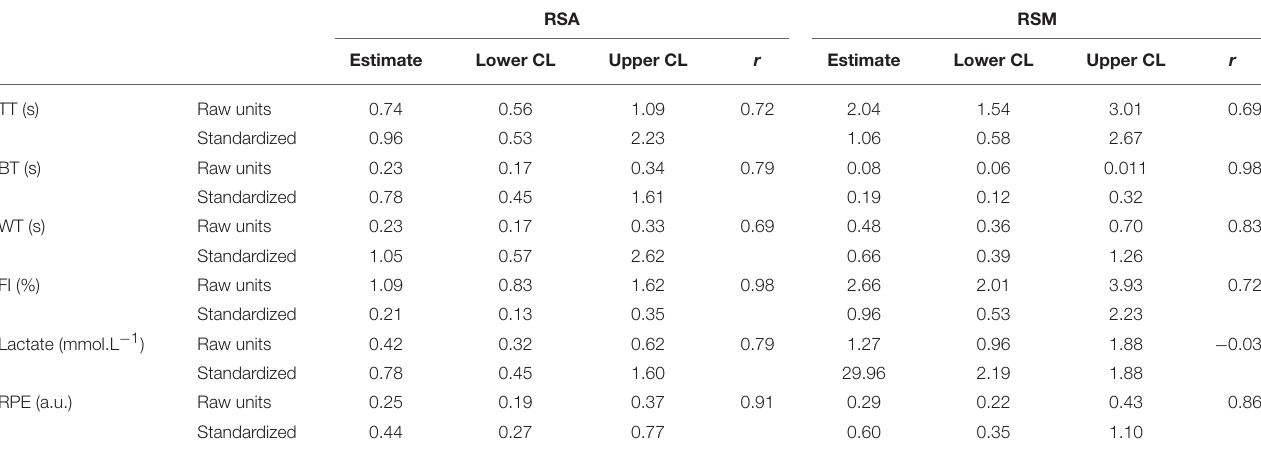
TABLE 3 | Typical Error of Measurement and correlation of measurements in RSA and RSM using Will Hopkins reliability